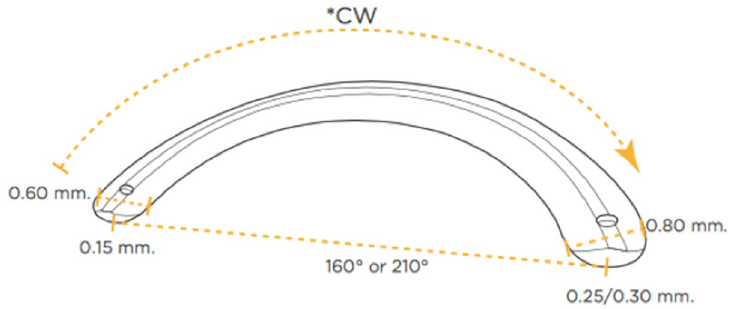
Fig 2. Geometry of the asymmetric